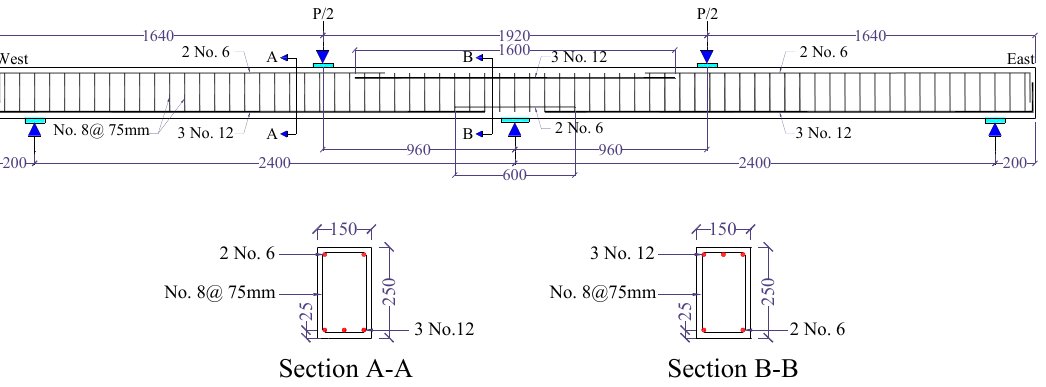
Figure 2. Details of steel reinforcement (dimensions are in mm).